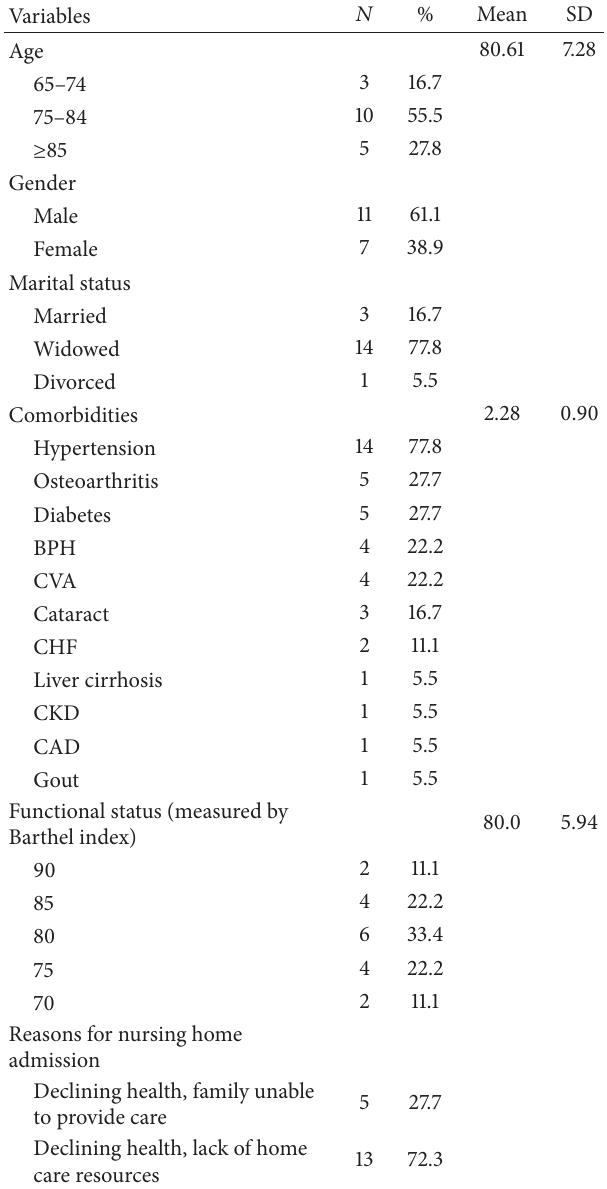
Table 1: Characteristics of research participants ( 𝑁 = 18